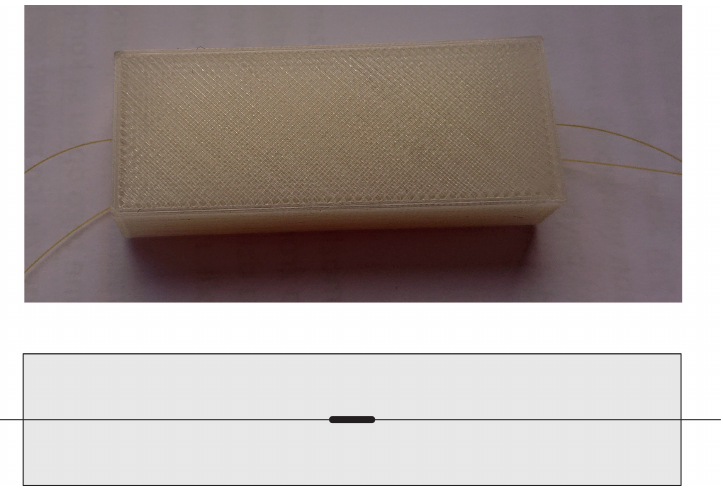
Figure 3. A photograph and cross-section scheme of the PLA